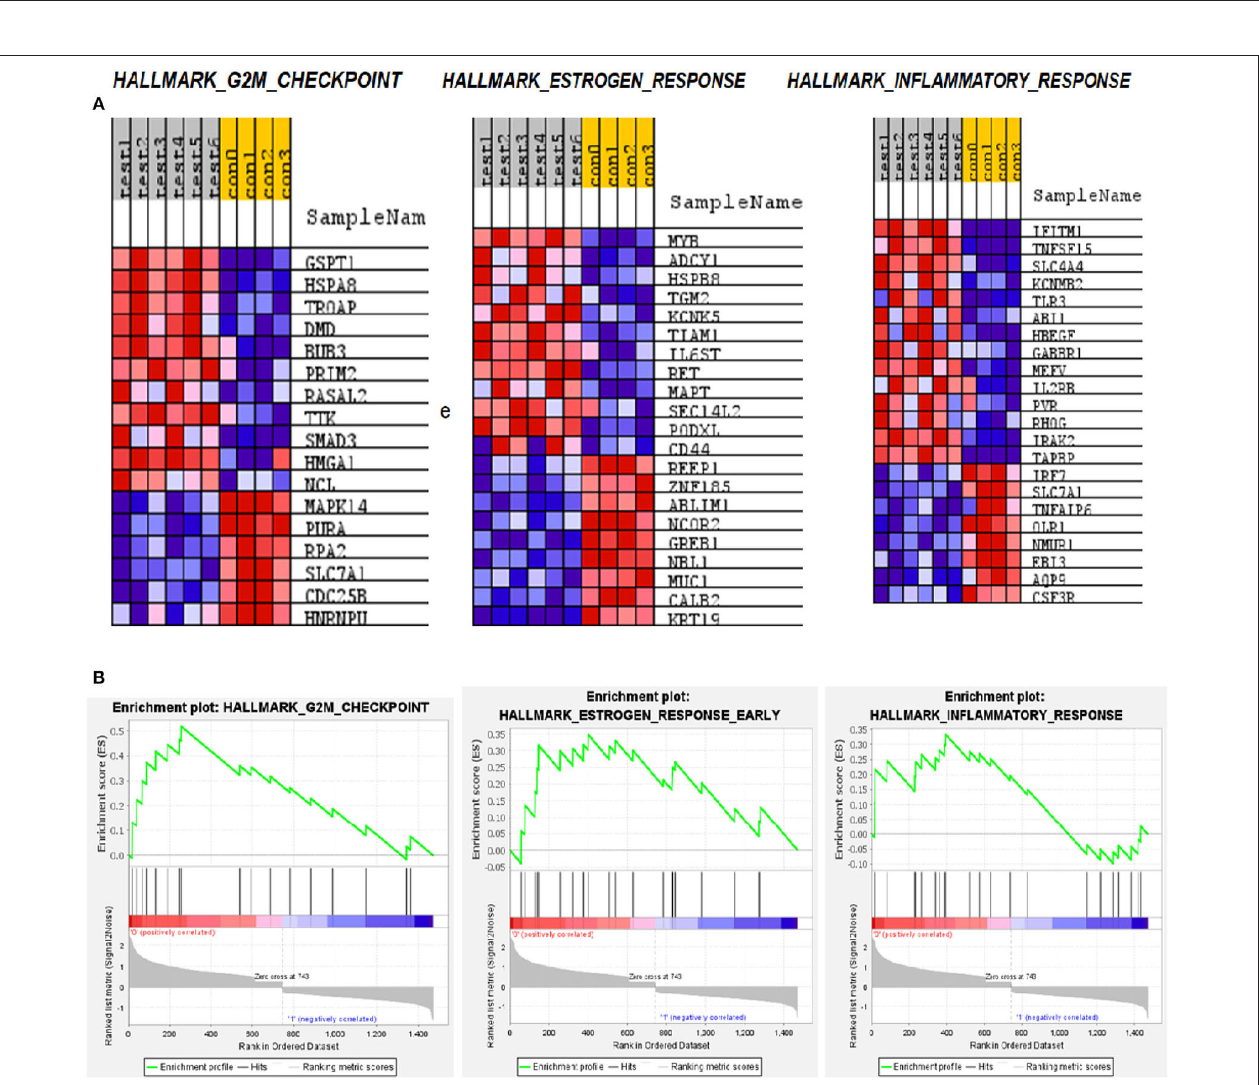
FIGURE 5 | Gene set enrichment analysis (GSEA) pathways for differentially expressed mRNA in LVNC. (A) Heatmap of the three most enriched pathways showing genes. (B) Enrichment score of these pathways.